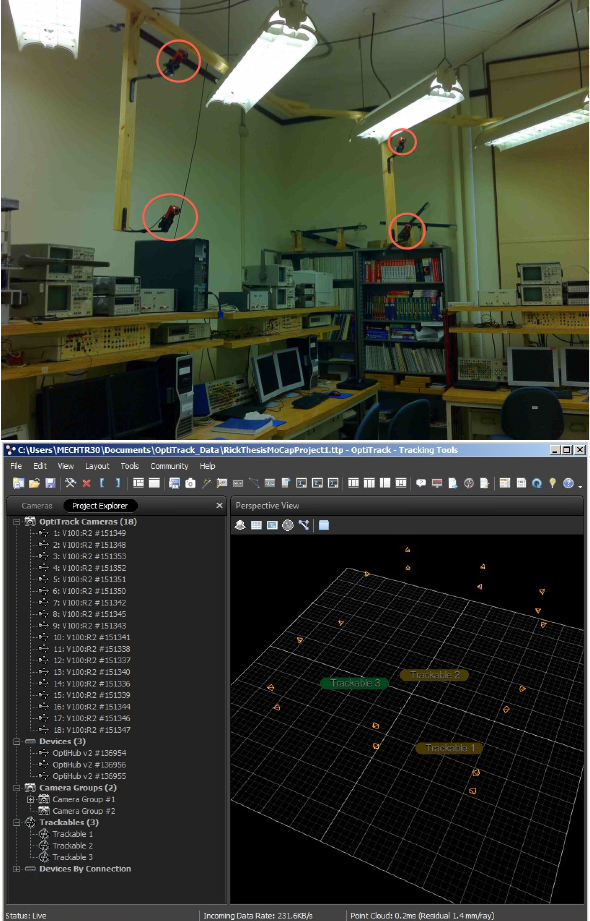
Fig. 9. Motion capture software and camera